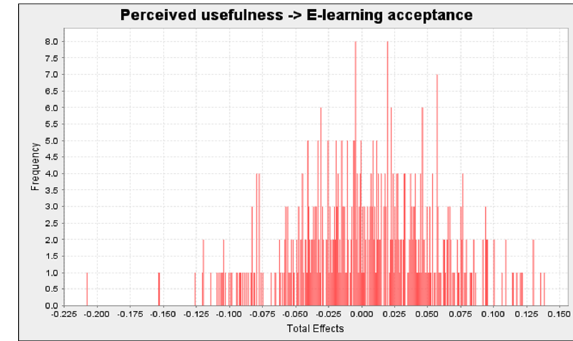
Fig. 5. The impact of perceived usefulness of the students on the behavioral intention to adopt